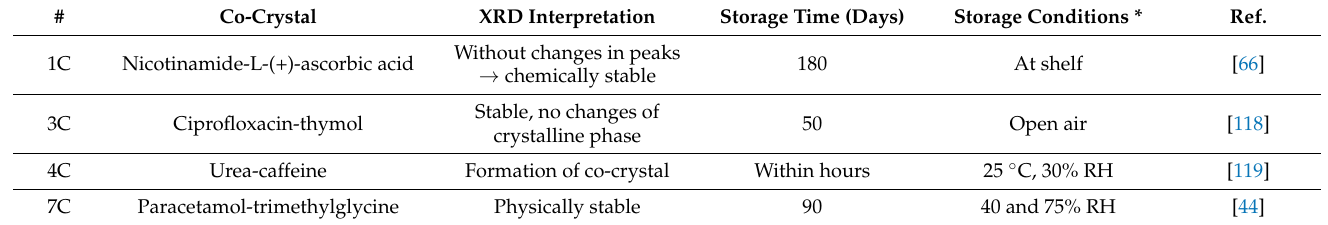
Table 15. Overview of structural stability of co-crystals upon storage in diverse